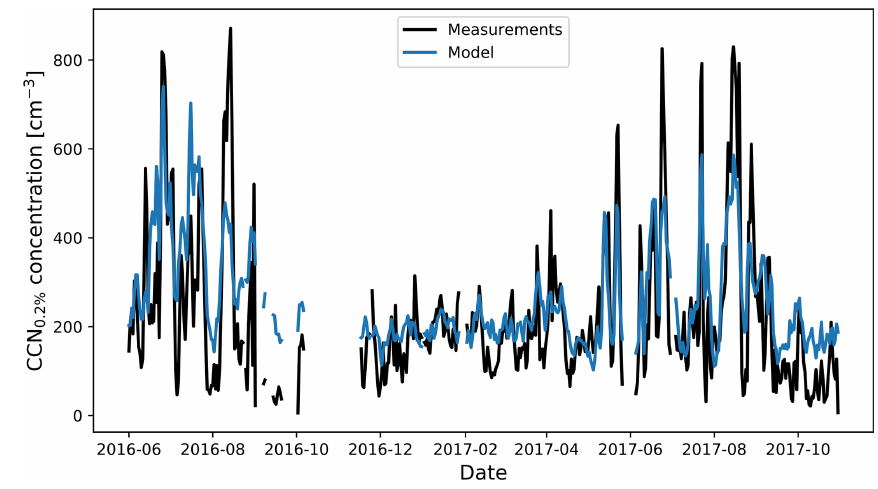
Figure 3. Comparison of the modelled and observed daily mean CCN concentration at 0.2% supersaturation (CCN 0 . 2% ). The measured CCN 0 . 2% is from the LASIC campaign; the modelled CCN 0 . 2% is from the baseline simulation and was interpolated to the LASIC coordi- nates.